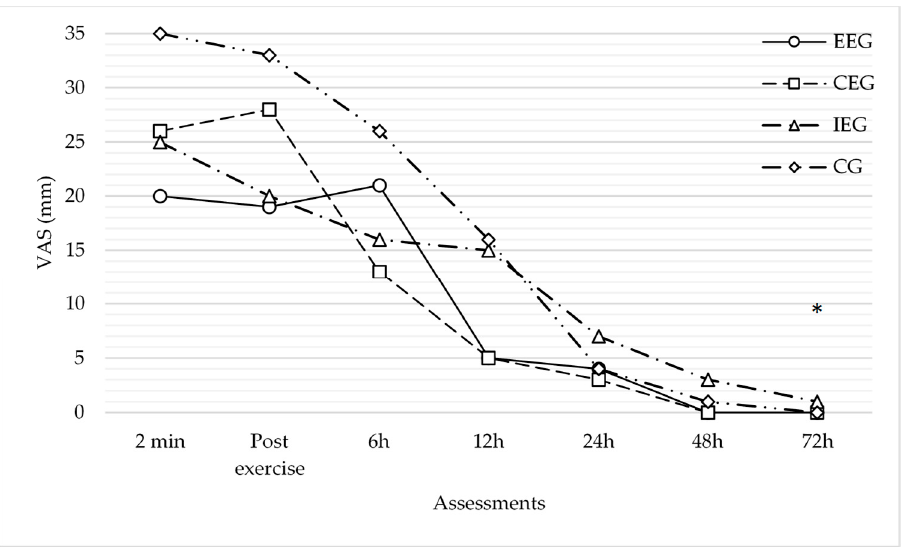
Figure 2. Comparison analysis of the change in the postneedling soreness intensity over time between groups. * Statistically significant p . p -values proceeding from multiple pairwise comparisons per time*group, adjusting for group (mixed ANOVA); comparisons between groups in each assessment (based on estimated marginal means). EEG, eccentric exercise group; CEG, concentric exercise group; IEG, isometric exercise group; CG, control group; VAS, visual analogue scale. The 5 × 4 mixed-model ANOVA showed a significant interaction between time and PPT F (3,170) = 6.53, p < 0.001, and η 2 = 0.09. Furthermore, a significant time*group interaction was found ( F (8) = 2.11, p = 0.04, and η 2 = 0.08). However, tests of effects between-subjects did not confirm a significant main effect of group on PPT ( p = 0.35 ). Therefore, by ignoring other outcomes, there was no statistical differences in PPT according to the group.